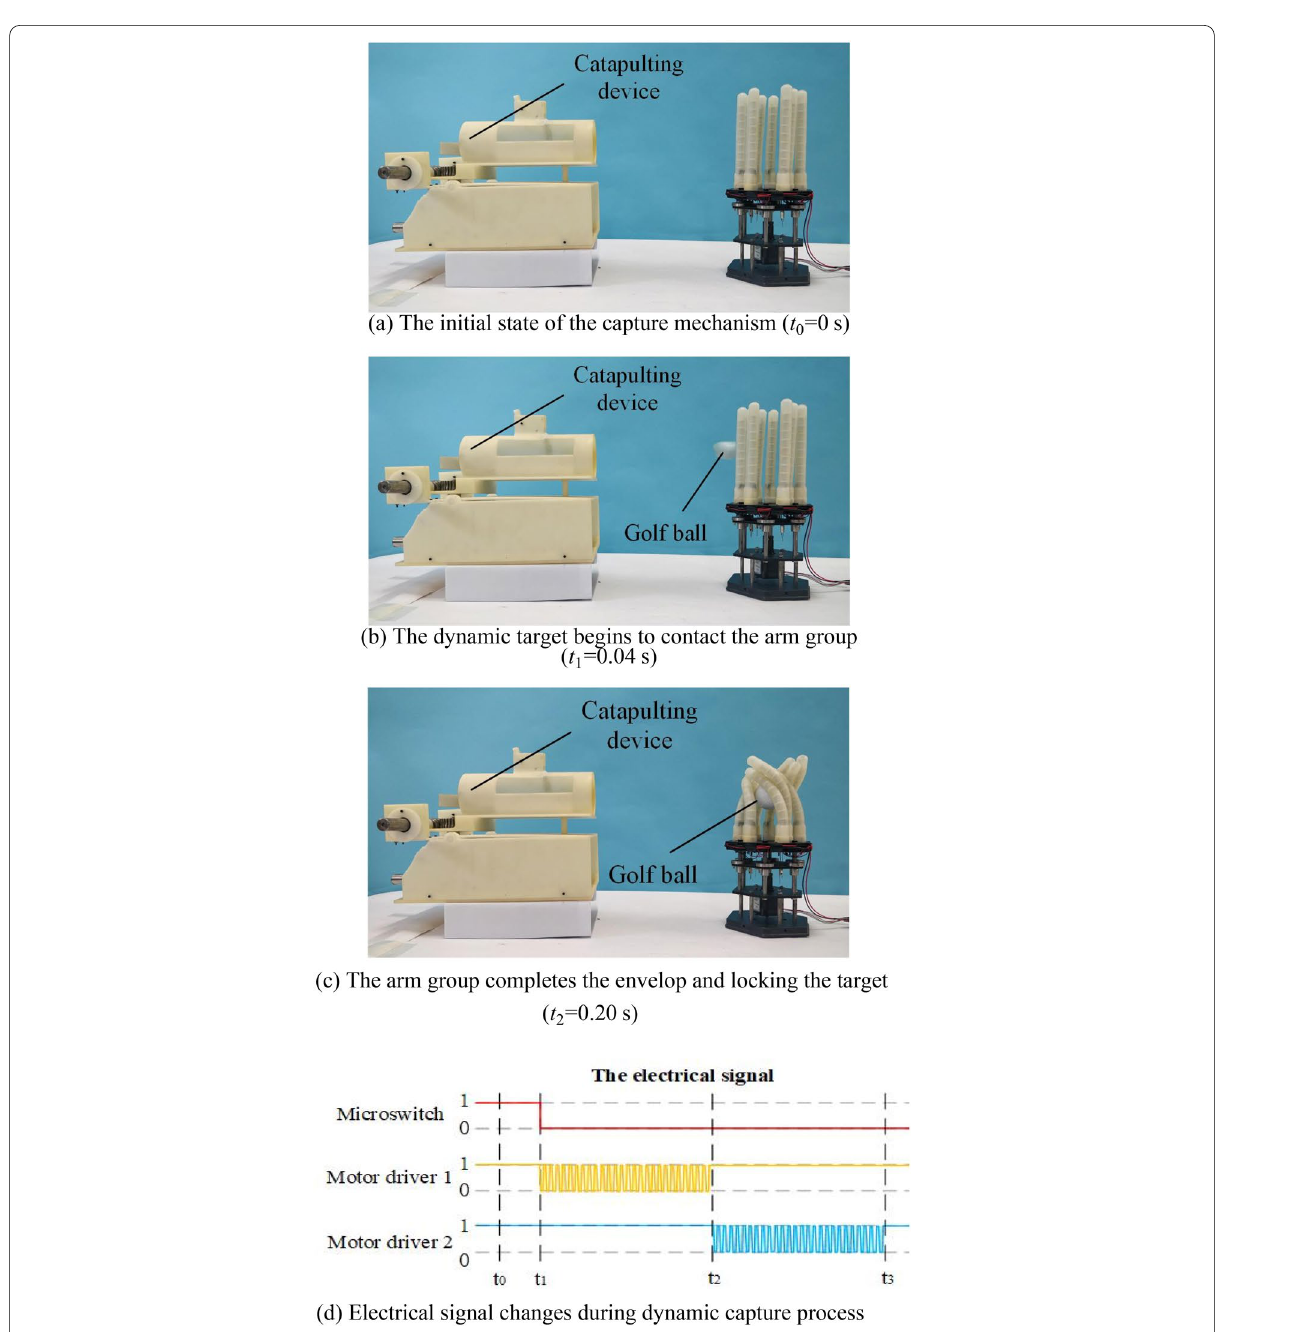
Figure 10 Dynamic capture of a golf